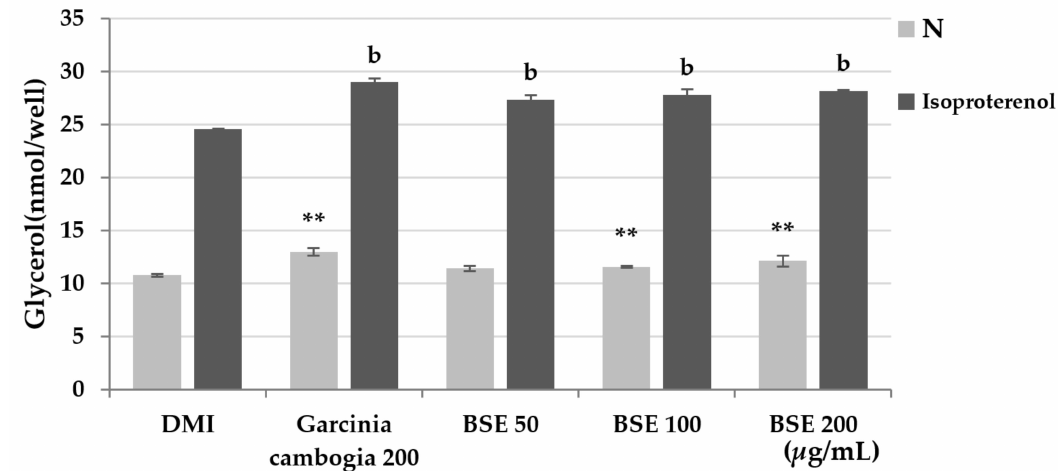
Figure 5. Effect of lipolysis induction by the hot-water extract of barley sprout (BSE). Statistical analysis was performed using one-way and two-way analysis of variance (ANOVA). ** p < 0.01 compared with DMI group. b p < 0.01 compared with DMI + isoproterenol group. N: no substance treatment; DMI: 1 µ M dexamethasone, 0.5 mM 3-isobutyl-1-methylxanthine, and 1 µ g/mL of